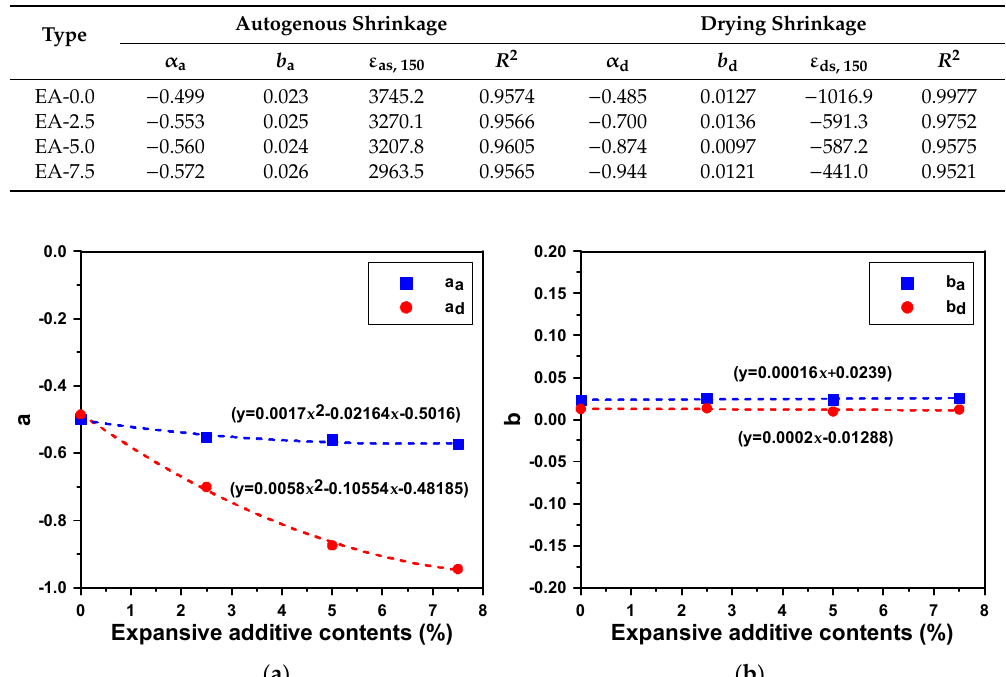
Table 6. Material constants of the exponential function model for autogenous and drying shrinkage.